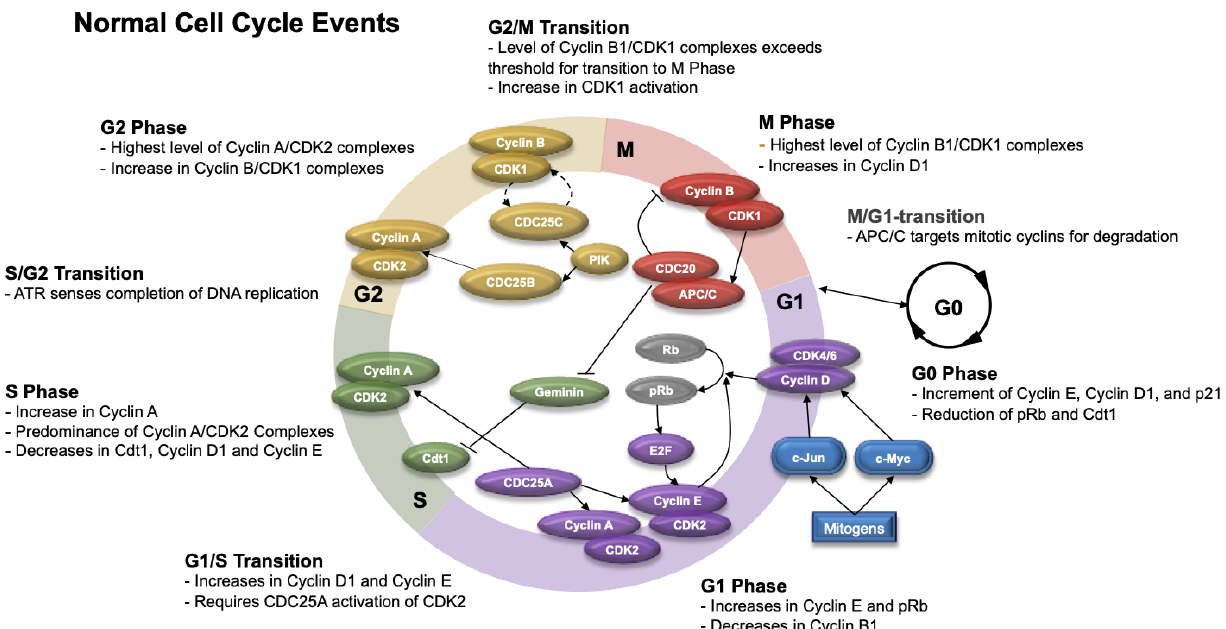
Figure 4. Diagram of the normal cell cycle. This diagram shows the G0, G1, S, G2, and M phases of the cell cycle, which are characterized by expression of various cyclins and proteins. Checkpoints exist throughout the cell cycle to ensure DNA integrity. APC/C (anaphase promoting complex), ATR (ataxia-telangiectasia and Rad3-related protein), CDC25 (cell division cycle 25), CDK1/2/4/6 (cyclin-dependent kinase 1/2/4/6), Cdt1 (chromatin licensing and DNA replicating factor 1), E2F (family of transcription factors), PIK (phosphatidylinositol kinase), pRB (phosphorylated retinoblastoma protein), Rb (retinoblastoma